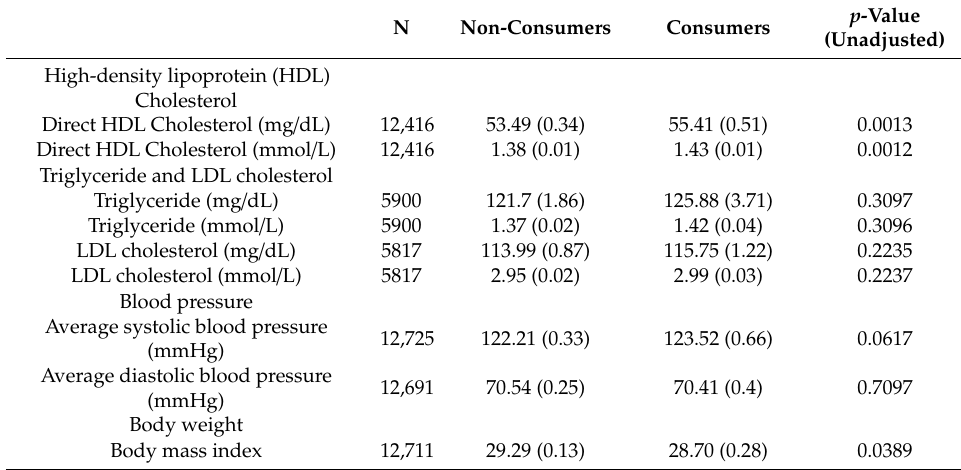
Table 6. Cardiovascular disease biomarkers and body weight among adults among tea consumers and